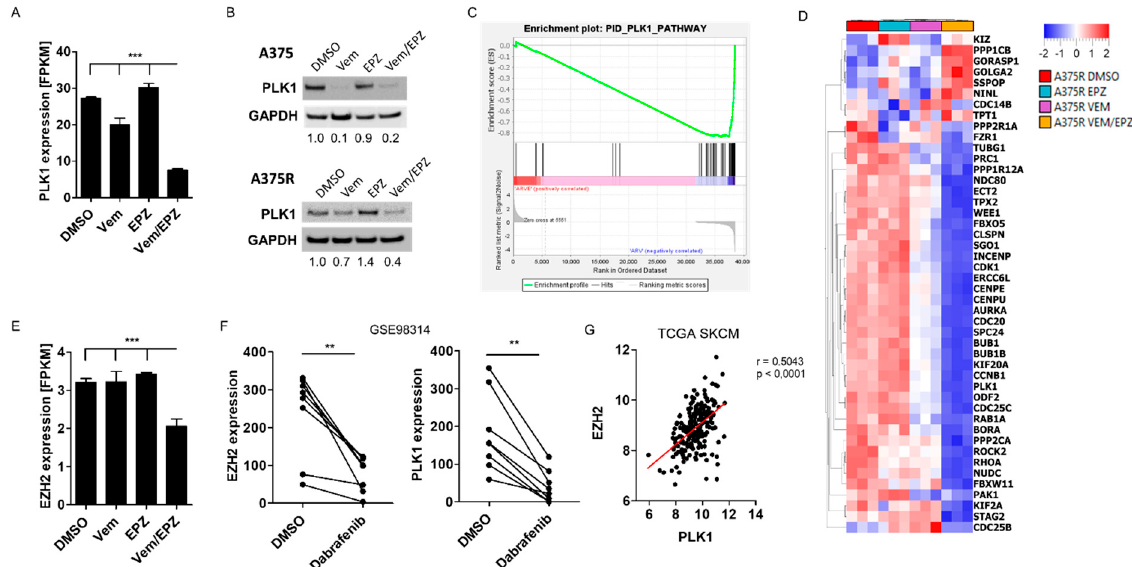
Figure 5. PLK1 expression is mediated by BRAFi and EZH2 signaling. ( A ) Polo-like kinase 1 (PLK1) expression (fragments per kilobase of transcript) in A375R cells treated with DMSO (control), EPZ (5 µM), vemurafenib (Vem) (10 µM) or vemurafenib and EPZ. ( B ) Western blot of A375 cells and A375R cells, treated with DMSO, vemurafenib (A375 1 µM or A375R 10 µM), EPZ (5 µM) or with vemurafenib and EPZ in combination, investigated PLK1 and GAPDH. ( C ) Enrichment plot for PLK1 pathway and ( D ) heatmap for genes downregulated by vemurafenib and EPZ in A375R cells. ( E ) EZH2 expression (fragments per kilobase of transcript) in A375R cells treated with DMSO (control), EPZ (5 µ M), vemurafenib (10 µ M) or vemurafenib and EPZ. ( F ) Analyses of EZH2 and PLK1 expression in eight BRAF-mutated melanoma cell lines treated with DMSO (control) or dabrafenib (GSE98314). ( G ) Correlation of EZH2 and PLK1 expression in BRAF-mutated melanoma patients (TCGA). (** p < 0.01; *** p <